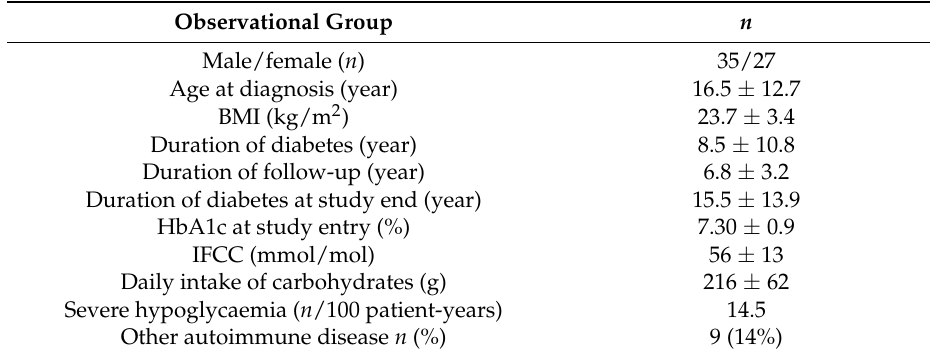
Table 2. Baseline characteristics of the observational cohort of people with type 1 diabetes on MDI and without CGMS ( n =